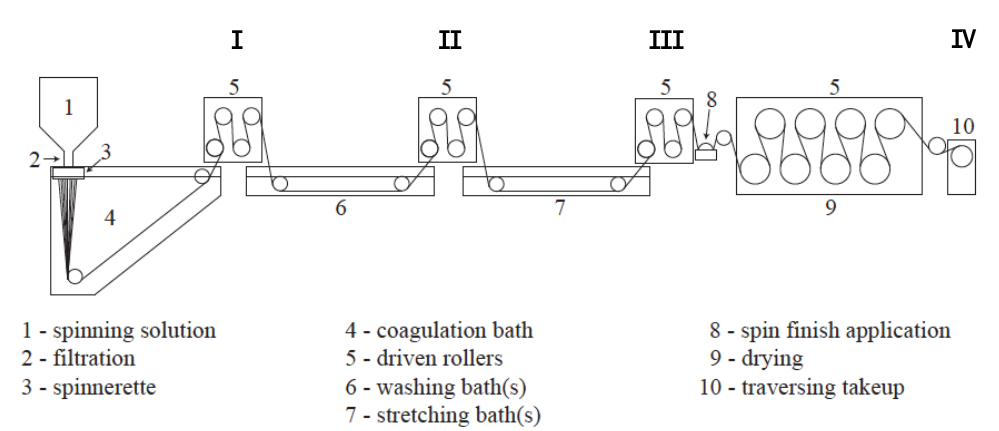
Figure 2. Solution spinning line at the University of Kentucky Center for Applied Energy Research (UKY CAER).